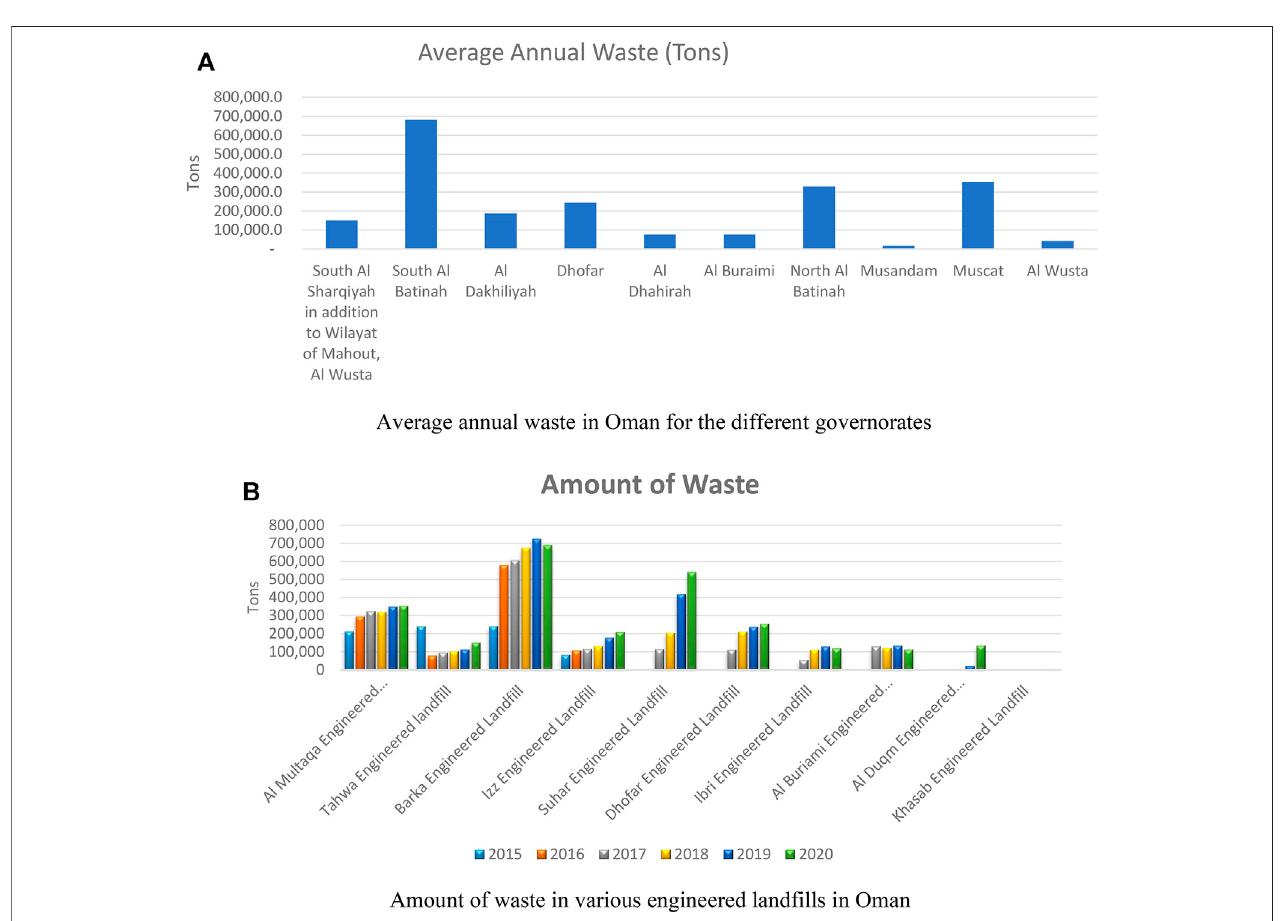
FIGURE14| AmountofwasteinOman. (A) AverageannualwasteinOmanforthedifferentgovernoratesand (B) amountofwasteinvariousengineeredland fi llsin Oman.